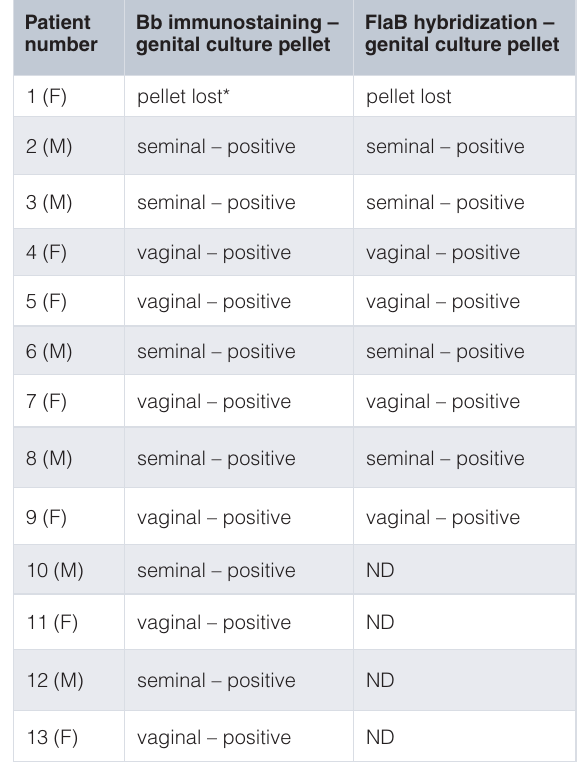
Table 4. Results of B. burgdorferi immunostaining and FlaB molecular hybridization in genital culture concentrates. See Dataset, data files 3 and 4. ND, not